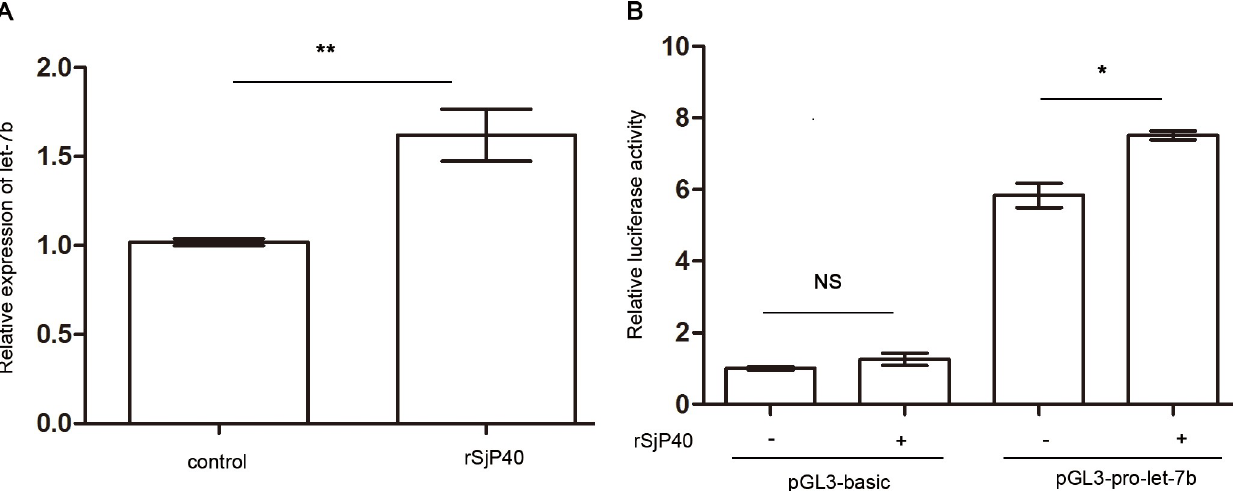
Fig 1. Expression of let-7b in LX-2 cells under rSjP40 stimulation. (A): Let-7b is highly expressed in rSjP40-treated LX-2 cells. (B): rSjP40 increases promoter activity of pGL3-pro-let-7b. � p < 0.05, �� p < 0.01, NS, p > 0.05, compared with the control group. Data were taken as mean ± SEM of at least three independent